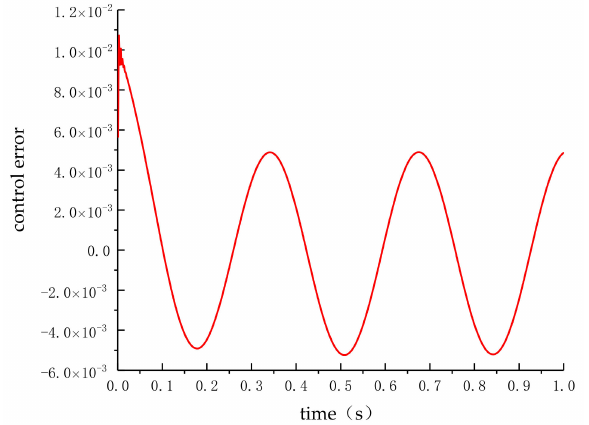
Figure 14. Control error curve.